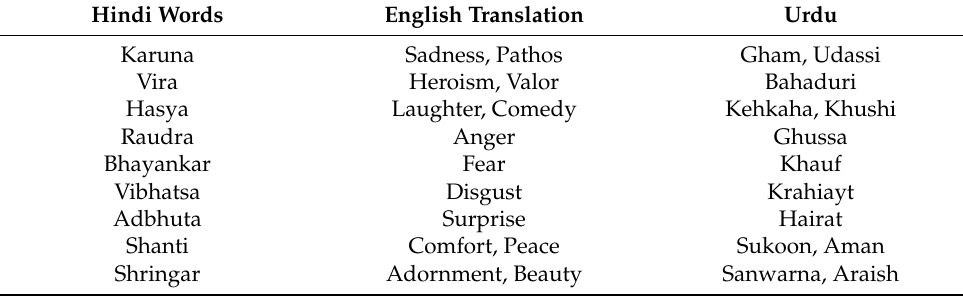
Table 1. Nine emotions in Indian aesthetic theory (Ruckert